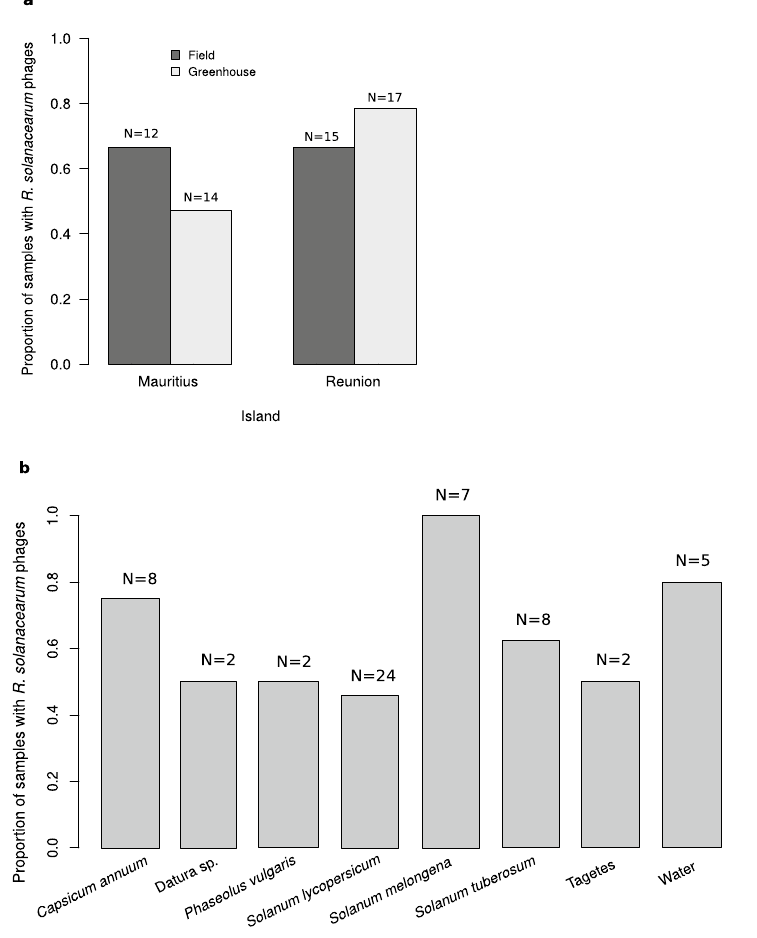
Figure 1. Proportion of samples positive for R. solanacearum phages, by island of origin and agricultural practices ( a ), and host plant or type of sample ( b